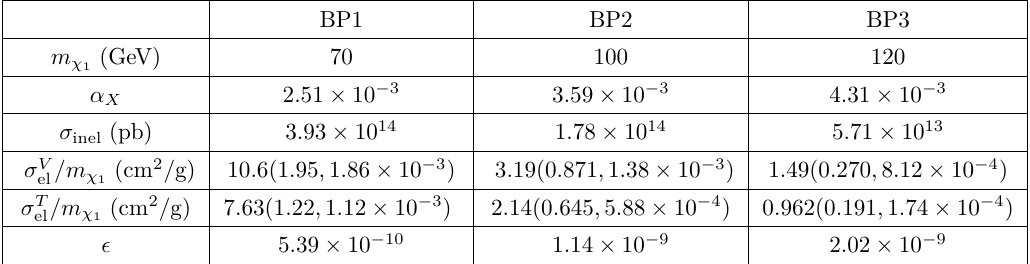
Table 1 . The results for the three benchmark masses m χ = 70 , 100 , 120 GeV. In the 2nd line the required dark gauge coupling constant α X to give the correct relic abundance, Ω DM h 2 = 0 . 119 , is given. In the 3rd–5th lines, the predictions of the cross sections for the inelastic scattering, σ inel ( χ 1 χ 1 → χ 2 χ 2 ) , and elastic scattering, σ V ( T ) ( χ 1 χ 1 → χ 1 χ 1 ) /m χ , are listed. We have el 1